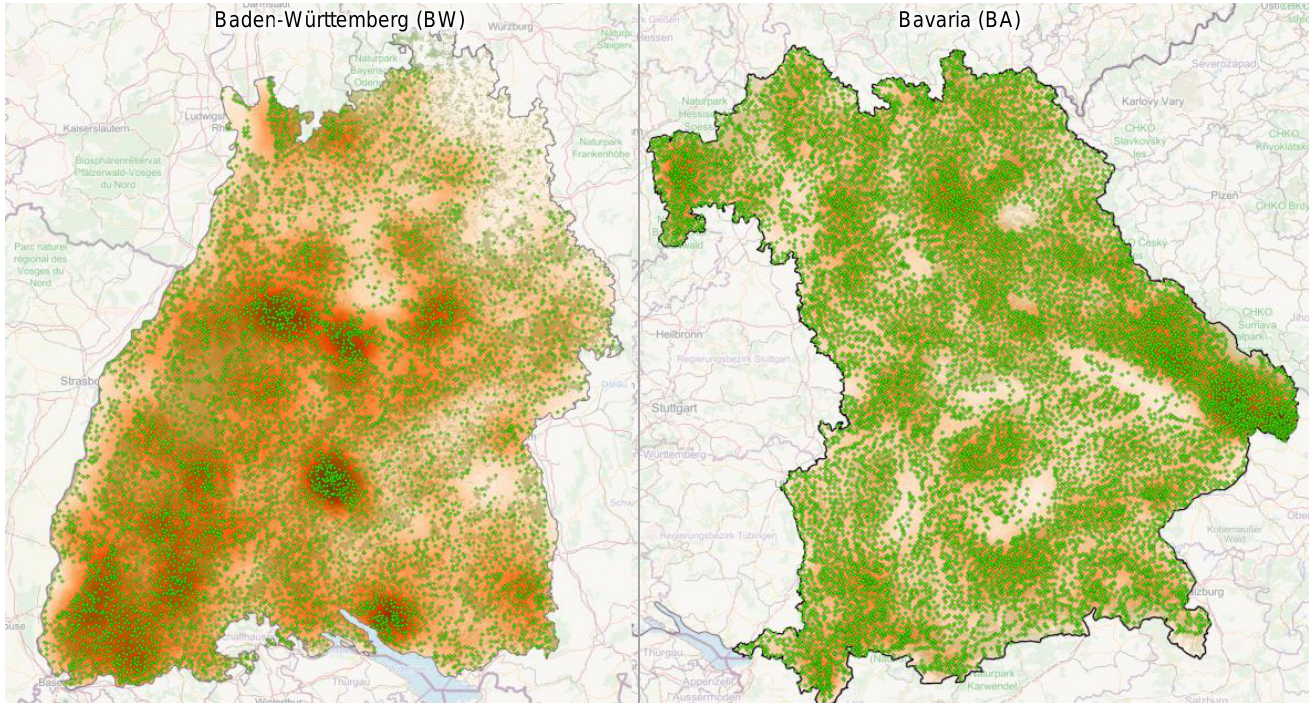
Figure 9. Illustration of existing rescue points (green cross) and calculated point density (the Figure X. Draw of existing rescue points (green cross) and calculated point density browner, the denser) as an example for two German federal states: Baden-Würtemberg ( left ) and (browner, the denser) as an example at two German federal states: Baden-Würtemberg Bavaria ( right (left) and Bavaria (right)